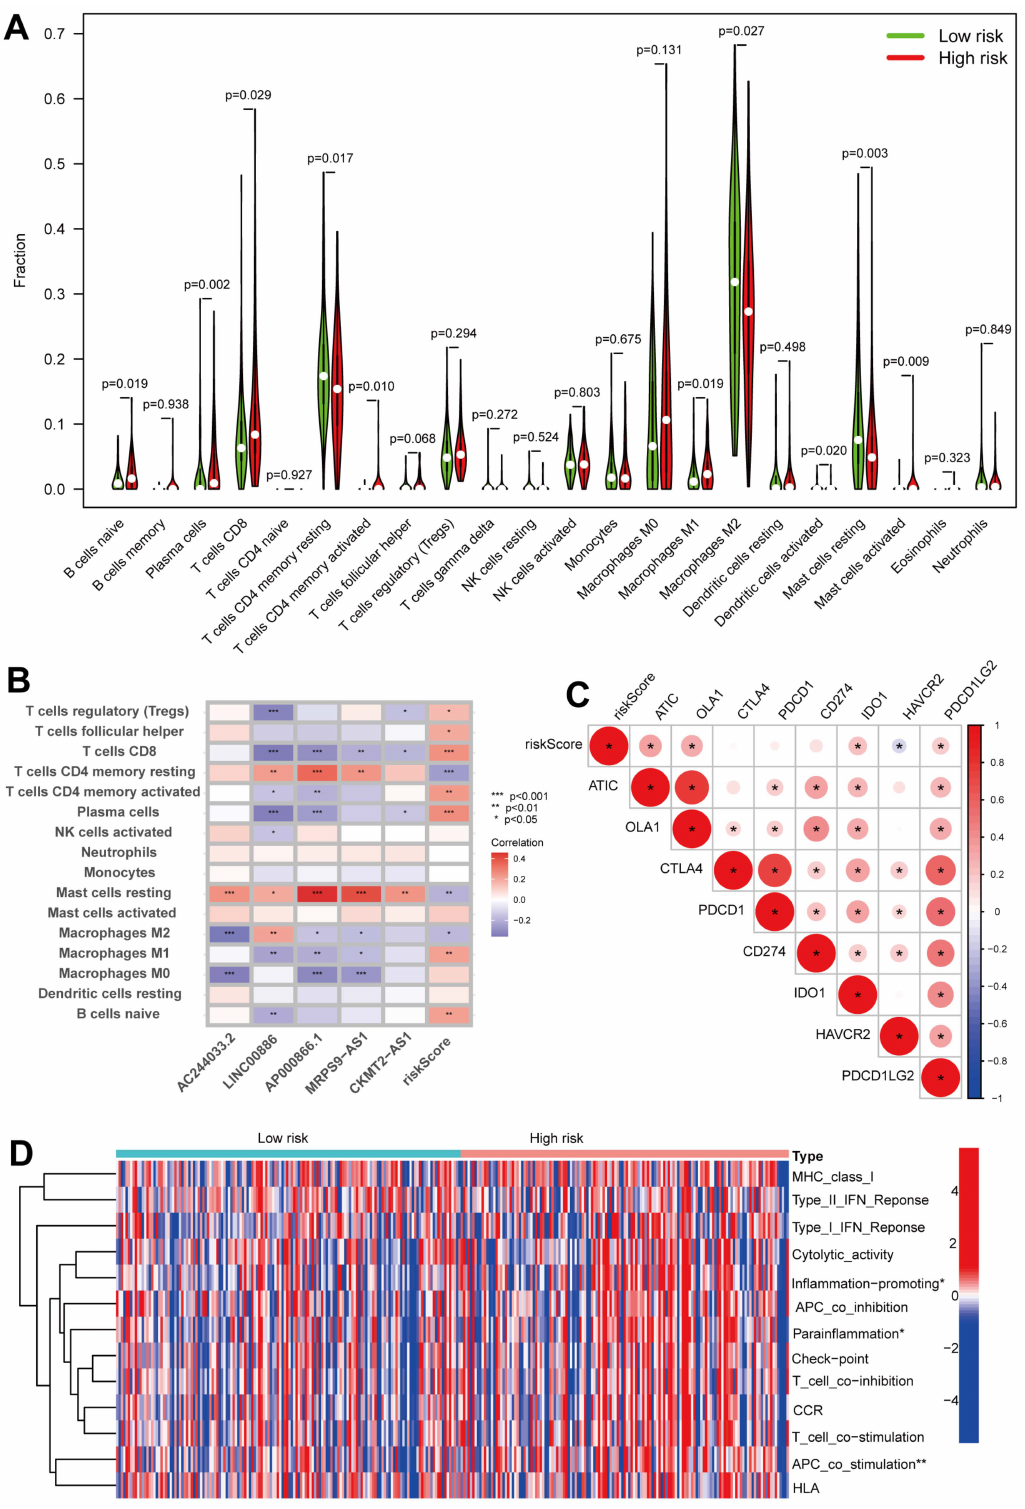
Figure 8. Analysis of the tumor microenvironment (TME) between the high- and low-risk patients. ( A ) Violin plot showing the fraction of 22 types of tumor-infiltrating immune cells for the low- and high-risk sets. ( B ) Correlation between infiltrating immune cells and 5 prognostic CRLs together with risk score. ( C ) An analysis of the correlation between immune checkpoints and risk scores. *, p < 0.05. ( D ) The heat map depicting an analysis of the immune function differences between the groups at low and high risk. *, p < 0.05; **, p <